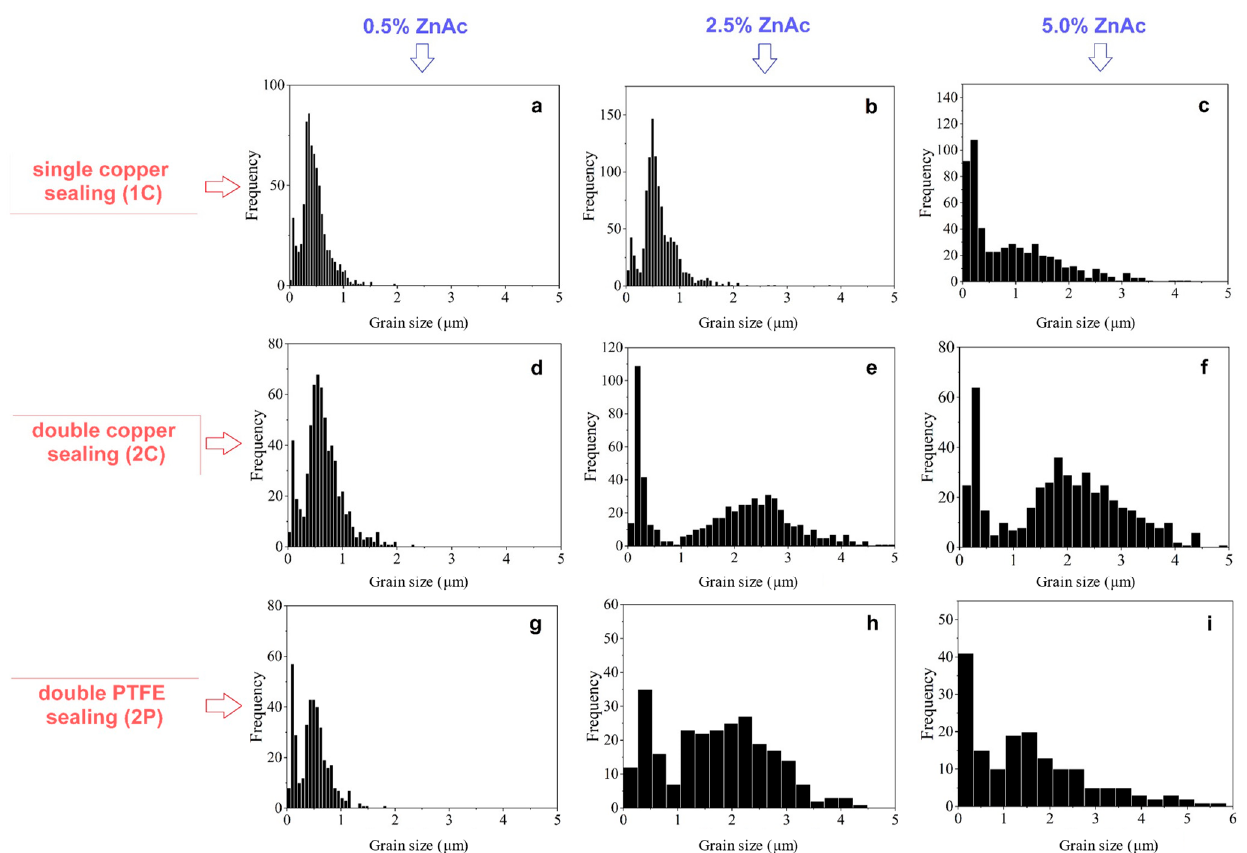
Figure 9. Grain size distributions of ceramics prepared from ZnO powder activated by impregnation and TVT ( a , d , g –0.5 wt.% of ZnAc; b , e , h –2.5 wt.% of ZnAc; c , f , i –5.0 wt.% of ZnAc after CSP with the use of different types of sealing.